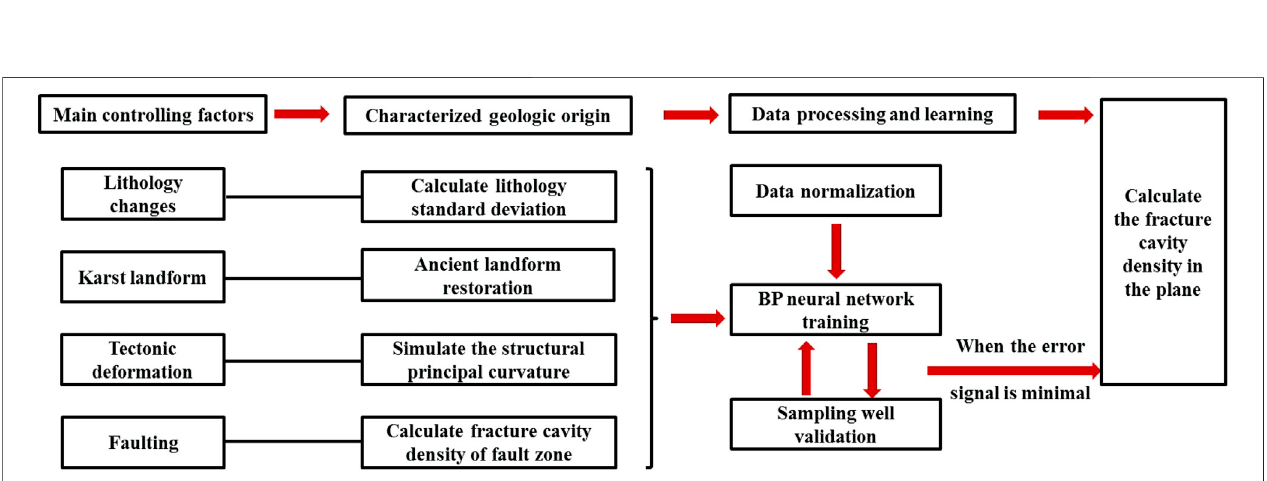
FIGURE 15 | Flowchart of fracture – cavity reservoir prediction.